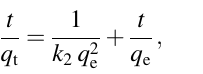
Fig. 9 a Pseudo-first-order model, b pseudo-second-order model, and c intraparticle diffusion model for the adsorption of AM onto